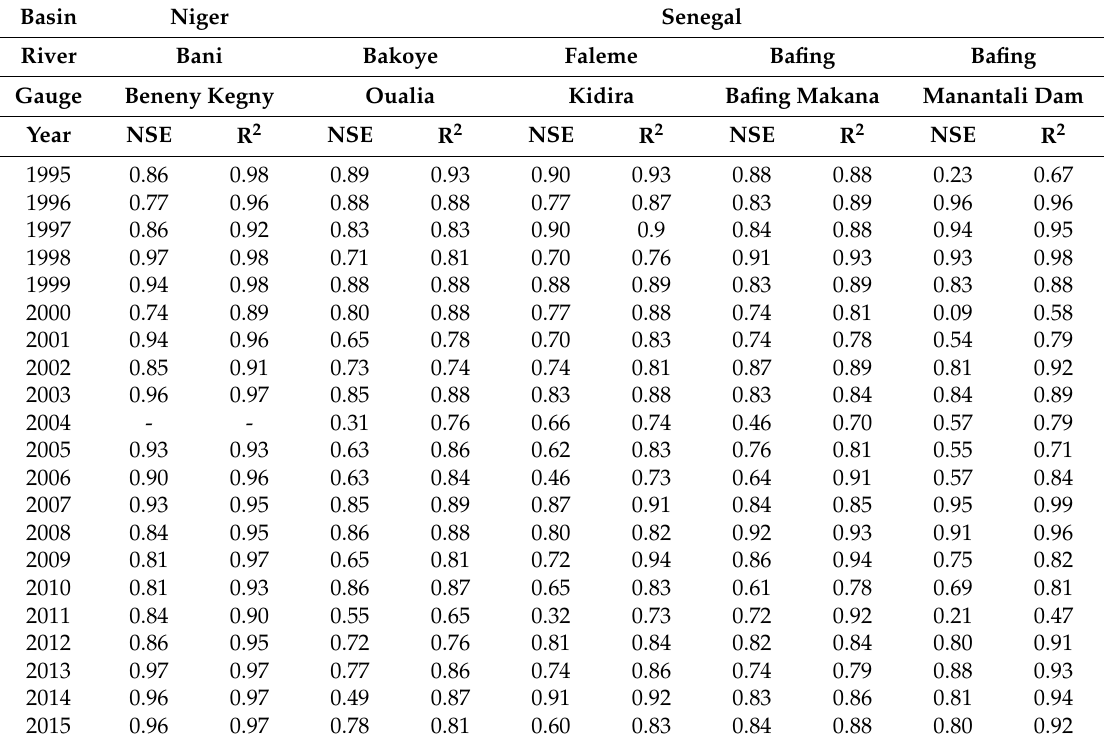
Table 4. Performance criteria of daily discharge simulations using original